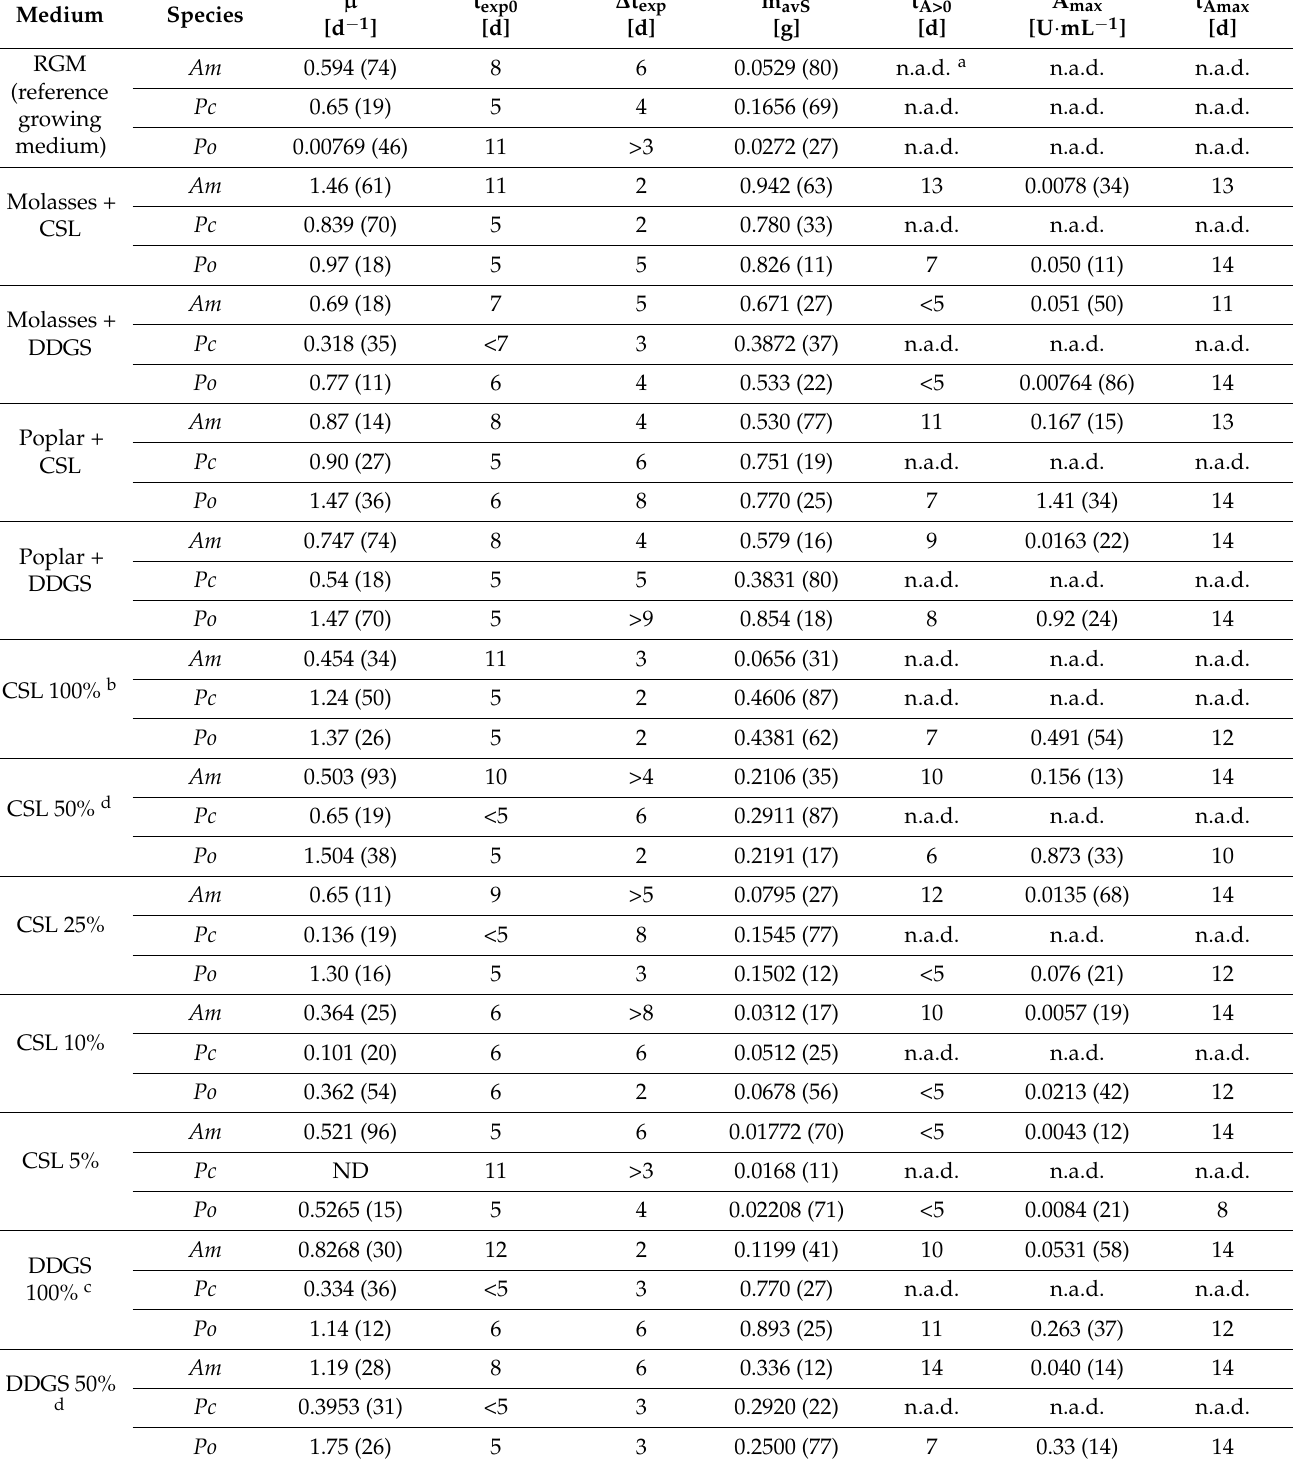
Table 4. Growth curves